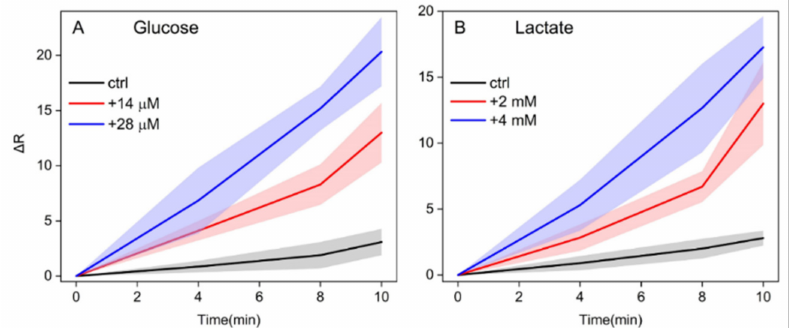
Figure 3. ∆ R values evolution over time of the detection zones after the assays on native saliva (black line), saliva spiked with the lowest (red line) and the highest (blue line) established non-physiological concentrations of ( A ) glucose (respectively, +14 and +28 µ M) and ( B ) lactate (respectively, +2 and +4 mM). The colored bands represent the standard deviation of 10 measurements performed on different salivary